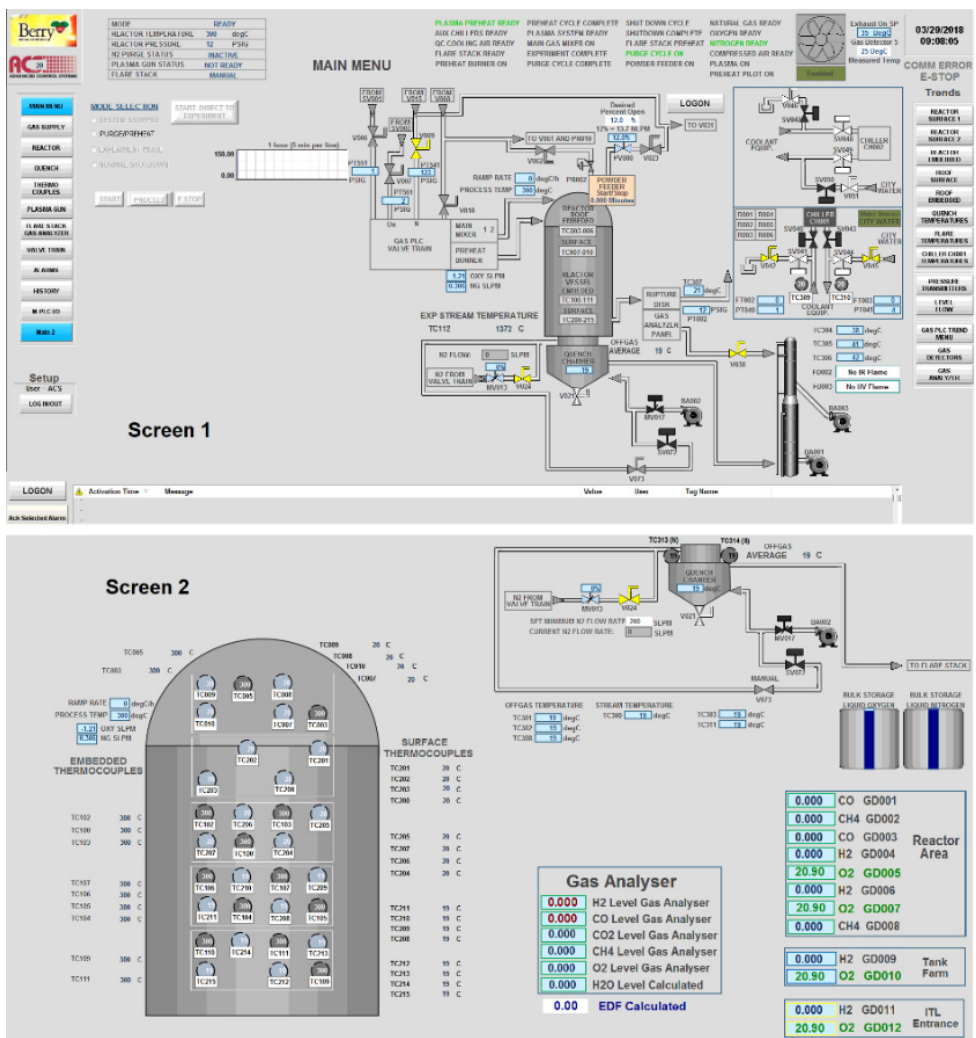
Figure 6. The controlling screen for the human machine interface (HMI).